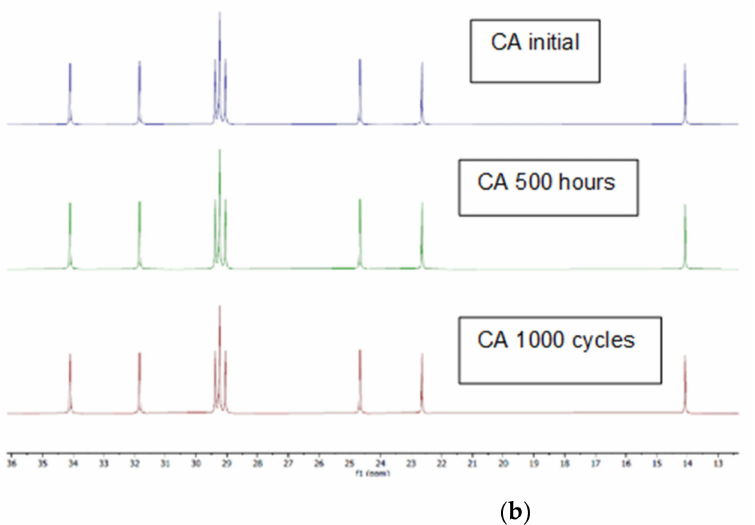
Figure 2. NMR results: ( a ) 1 H spectra of myristic acid samples ( b ) 13 C spectra of capric acid